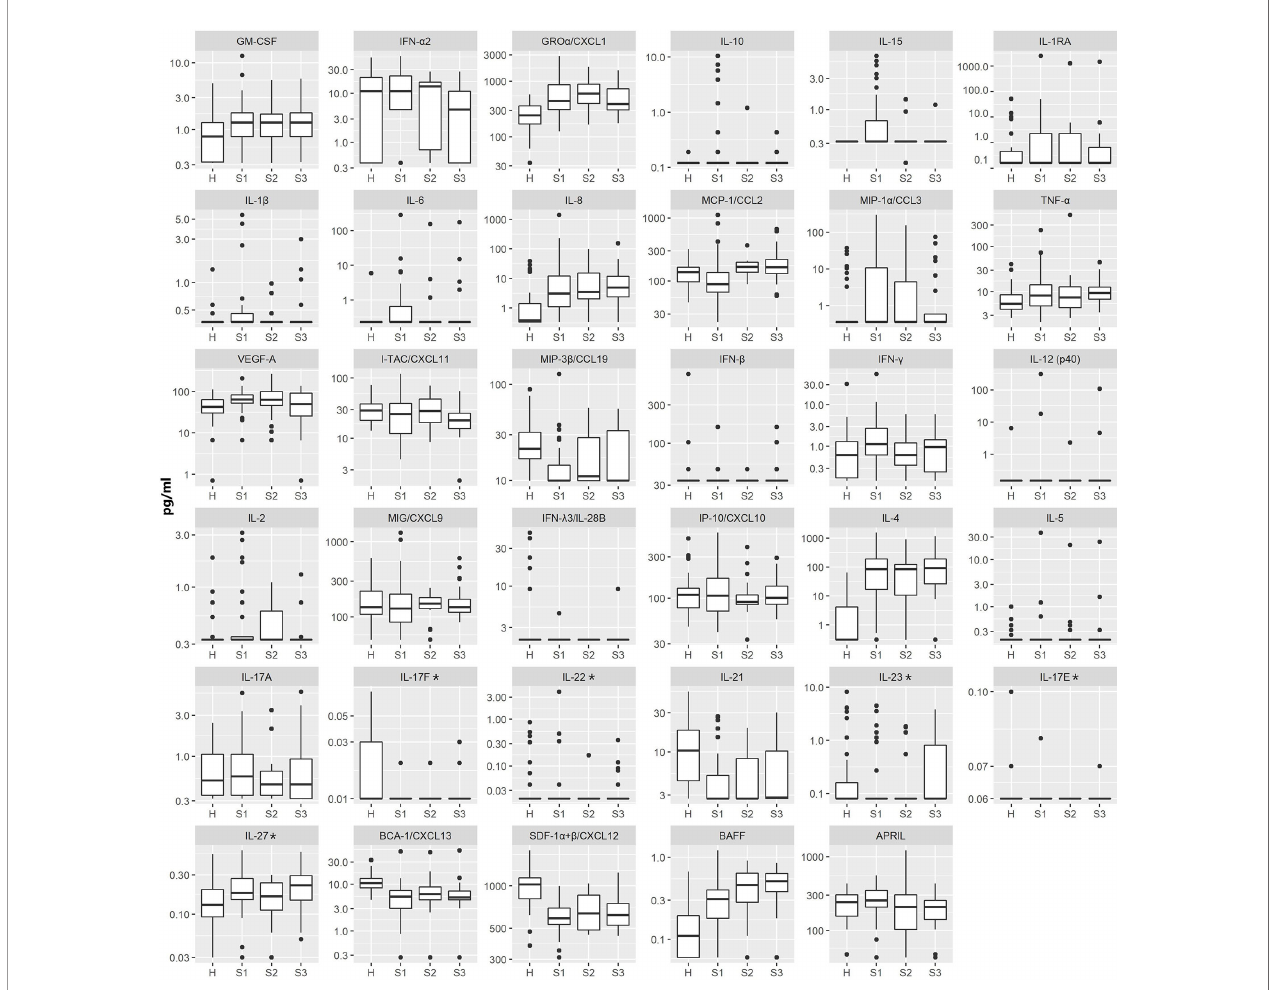
FIGURE 4 | The concentrations of 35 immune mediators in serum samples of healthy individuals (H) and VBT TBE patients obtained on admission to the hospital (S1; n = 41), two to three weeks later (S2; n = 18) and one to two months (S3; n = 24) after the onset of neurological symptoms. Concentrations of immune mediators are in pg/ml, except those, marked with an asterisk are in ng/ml. Innate immune mediators: GM-CSF, IFN- a 2, GRO a /CXCL1, IL-10, IL-15, IL-1RA, IL-1 b , IL-6, IL-8, MCP-1/CCL2, MIP-1 a /CCL3, TNF- a , VEGF-A, MIP-3 b /CCL19, IFN- b ; Th1 immune mediators: IFN- g , IL-12 (p40), IL-2, MIG/CXCL9, IFN- l 3/IL-28B, IP-10/ CXCL10, I-TAC/CXCL11; Th2 immune mediators: IL-4, IL-5; Th17 immune mediators: IL-17A, IL-17F, IL-22, IL-21, IL-23, IL-17E, IL-27; B cell immune mediators: BCA-1/CXCL13, SDF-1 a + b /CXCL12, BAFF,